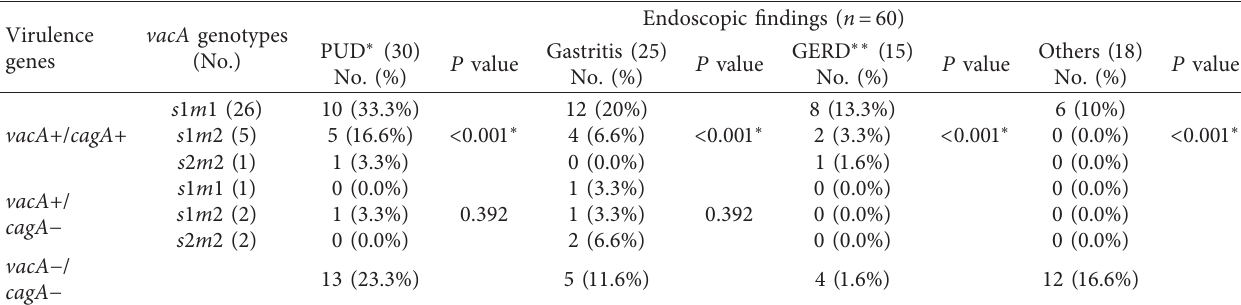
Table 3: Association between virulence genes and endoscopic findings in H. pylori strains (no. �